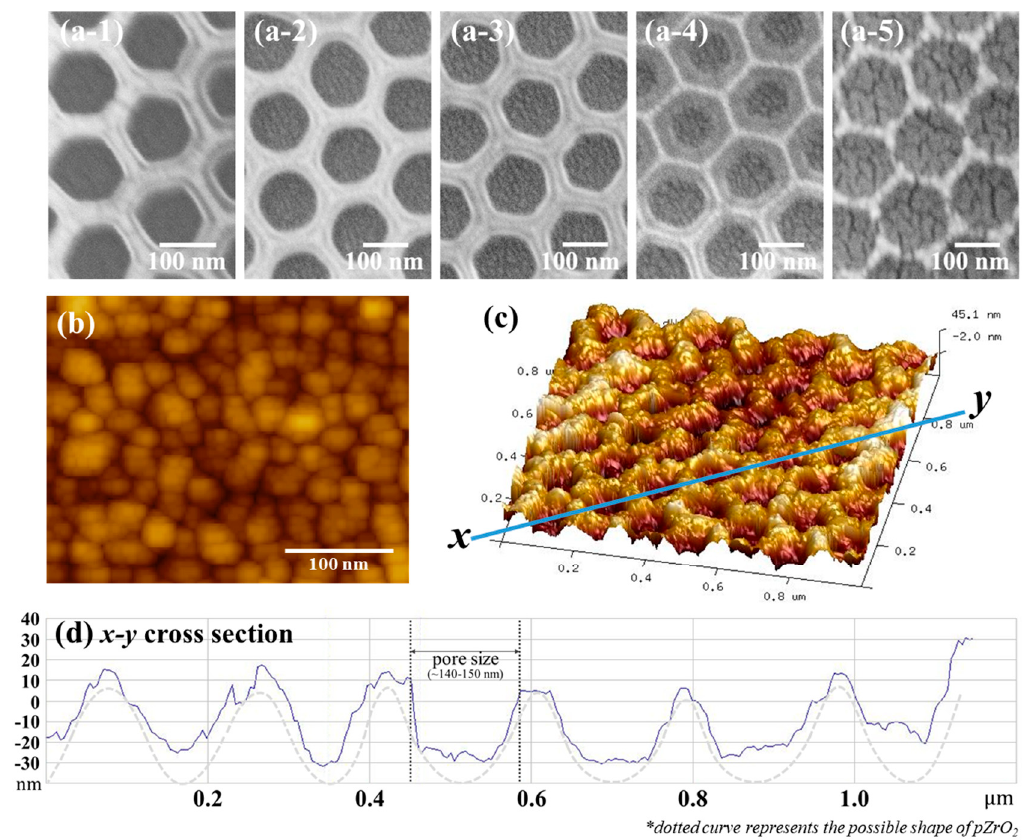
Figure 2. Surface morphologies of the fabricated Au NPs / p ZrO 2 : ( a ) SEM images from left to right— p ZrO 2 , Au NPs (1.5) / p ZrO 2 , Au NPs (2.0) / p ZrO 2 , Au NPs (3.0) / p ZrO 2 , and Au NPs (5.0) / pZrO 2 shows the morphological evolution of the substrate in terms of Au NP deposition thickness; ( b ) 2D AFM image shows the estimated sizes of the Au NPs; ( c ) 3D AFM image of Au NPs (3.0) / p ZrO 2 clearly shows the presence of porous cavities as formed by the ZrO 2 ; ( d ) Cross-sectional profile of the structure corresponding to the x-y line in Figure 2c confirms the structure of the porous ZrO 2 .